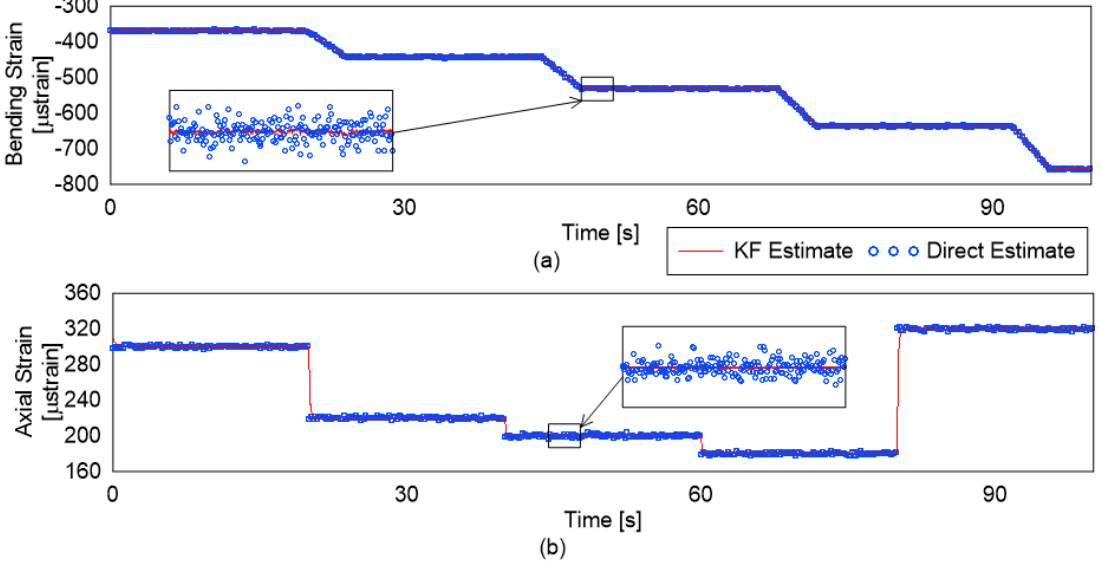
Figure 7. Strain estimation by DE- and KF-based estimation: ( a ) bending strains; and ( b ) axial strains.